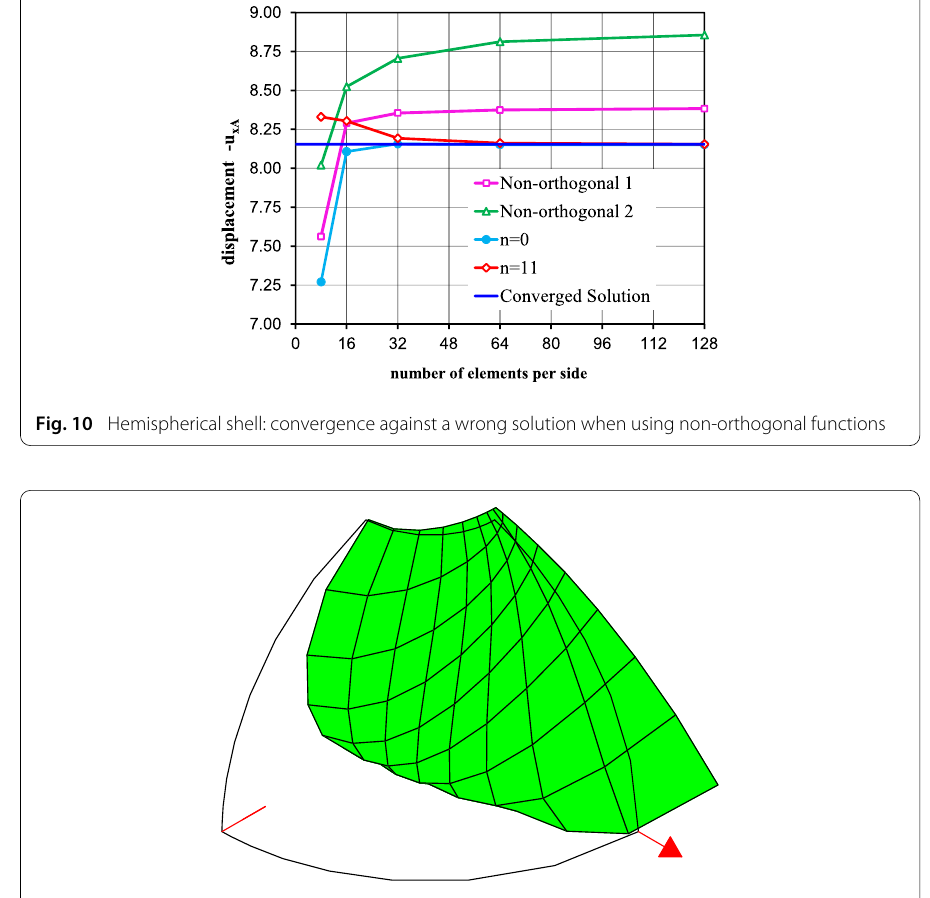
h = R / 10 , 000 and E = 2 . 1 · 10 6 , ν = 0. Figure 13 depicts load displacement